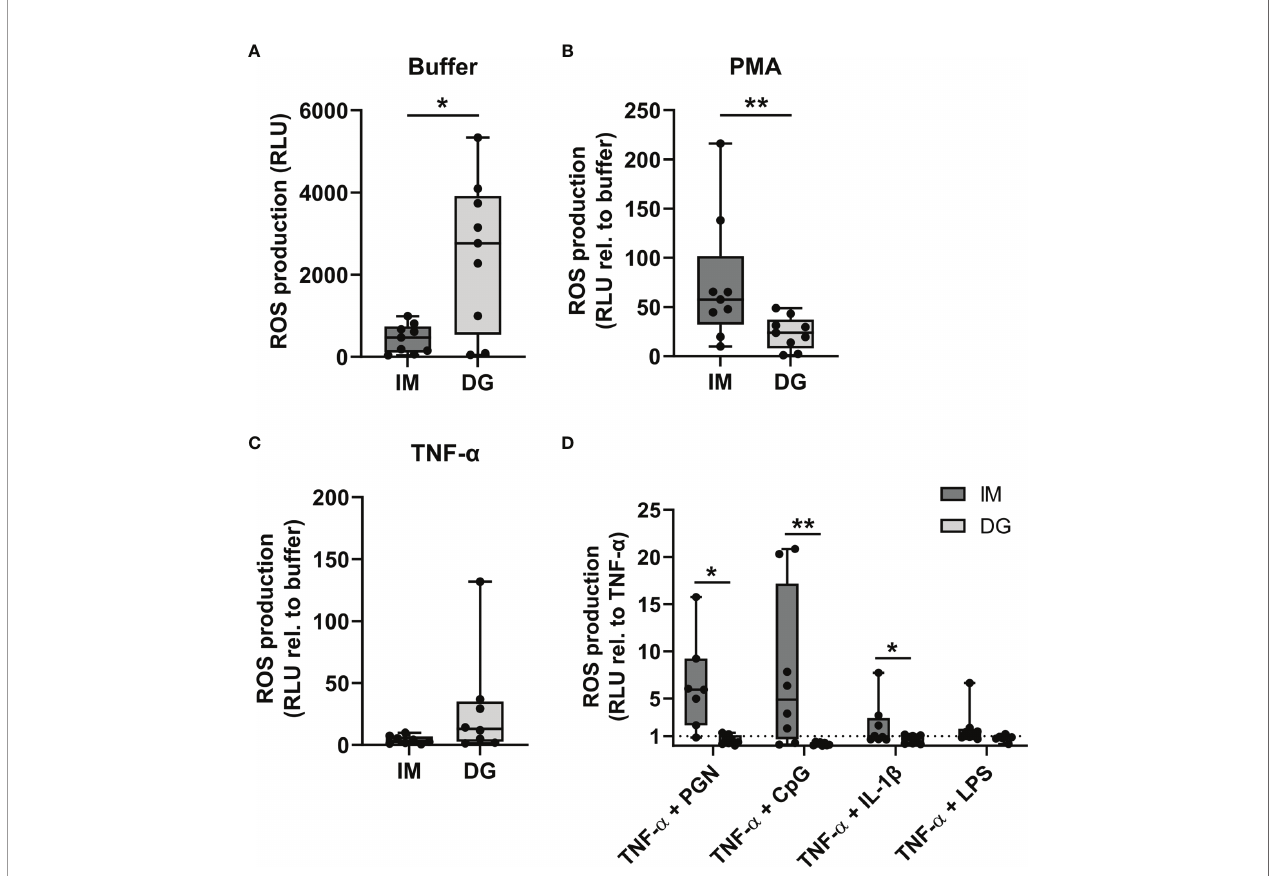
FIGURE 3 | Neutrophils puri fi edbyimmunomagneticisolationreleasemoreROSfollowing primingwithTNF- a .Peripheralbloodneutrophils wereisolatedbyimmunomagnetic (IM) ordensity-gradient(DG) puri fi cation.ROSproductionwasassessedbykineticmeasurementsofluminoloxidationduring1.5hoursafter stimulationwith (A) buffer, (B) 150ng/ mlPMA or (C) 50ng/mlTNF- a .Resultsarerepresentedasrelativelightunits(RLU) forunstimulatedneutrophils(onlybuffer) orasthefoldchangeinRLUrelativetothe corresponding buffer valuesfor thestimulatedneutrophils. (D) Neutrophilswerepretreated(primed) with50ng/mlTNF- a during10minutesat 37°C,followedbystimulationwith 10 µg/mlPGN,3µMCpG,500ng/mlIL-1 b , or 10µg/mlLPS. Kineticmeasurementsofluminoloxidationwereperformedduring 1.5hours.Resultsarerepresentedasthefold changeinRLUrelativetostimulationwithTNF- a alone. Dataareshownasbox-and-whiskerplots(box:medianwithinterquartile range, whiskers: fulldata distribution), witheach dot representinganindividualhealthydonor(n=8-9). ResultswerestatisticallyanalyzedbyWilcoxonmatched-pairs signedranktest(*p< 0.05;**p<0.01 forstatistical differencesbetweenneutrophilspuri fi edwithimmunomagneticor